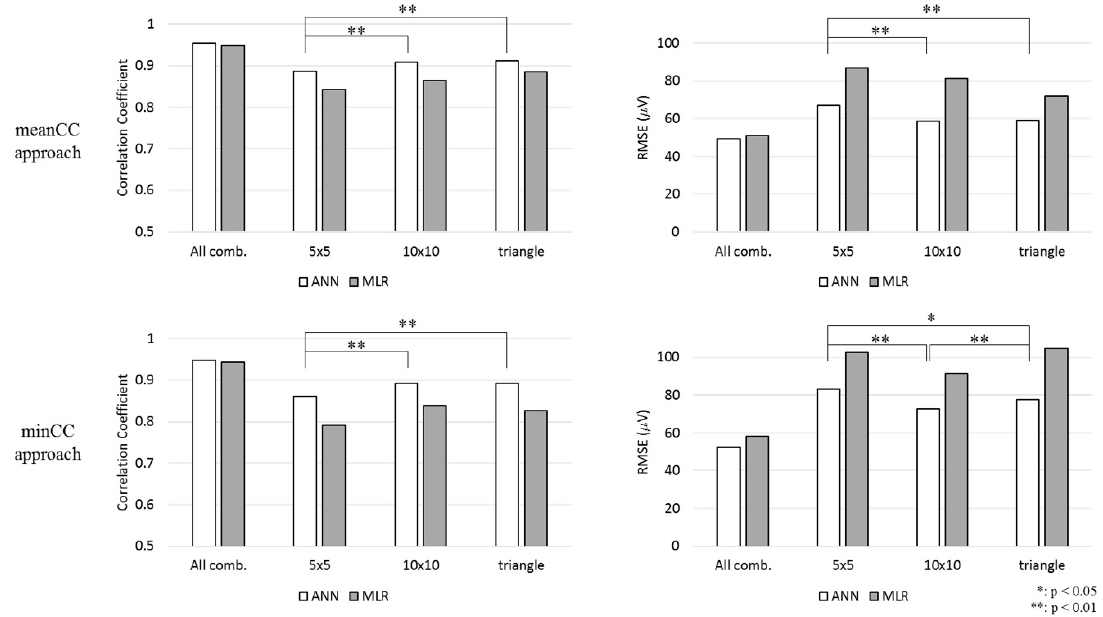
Figure 4. CC and root mean square error (RMSE) values of the electrode combination that showed the highest CC for each shape.